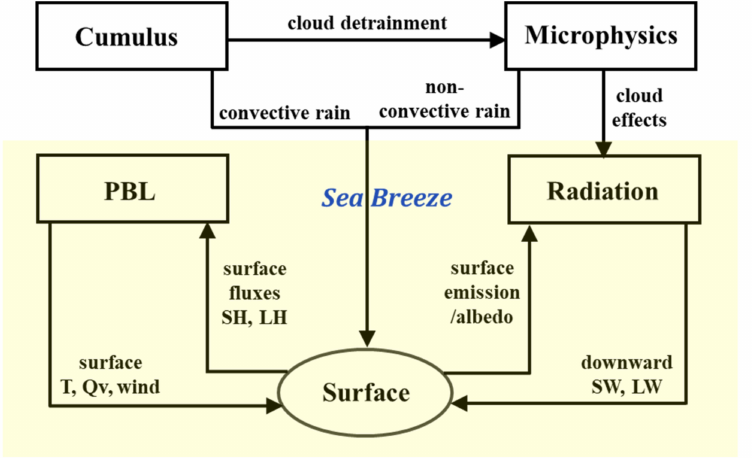
Figure 2. Schematic diagram representing direct interactions among the parameterized physical process. Acronyms SW and LW represent the shortwave and longwave radiation, respectively; SH and LH indicate the sensible heat and latent heat flux, respectively. Variables T and Qv mean temperature and water vapor mixing ratio, respectively. Reproduced with permission from Dudhia, A history of mesoscale model development [30]; published by the Korean Meteorological Society and Springer,